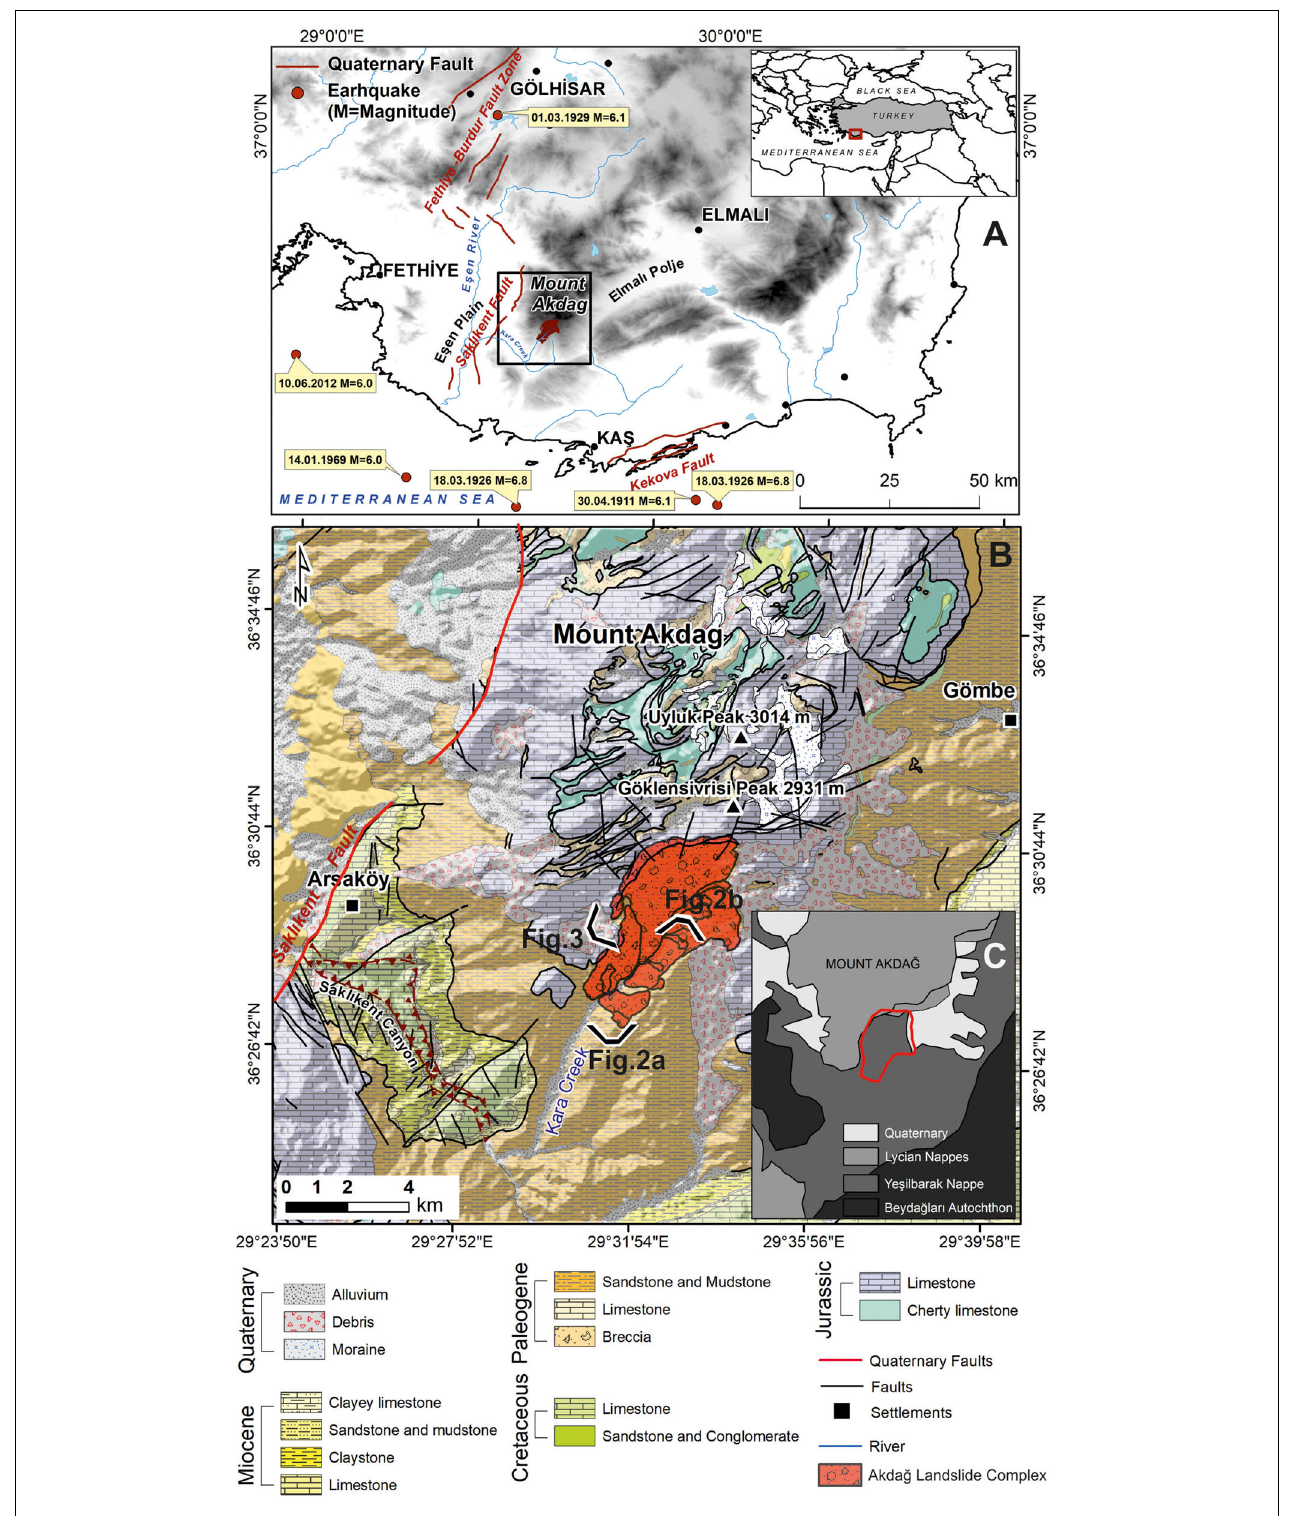
FIGURE 1 | (A) Location of Akdag Massif in southwest Turkey indicating active Quaternary faults and instrumental earthquakes and their magnitudes. (B) Generalized geology of Akdag Massif and its surroundings, SW Turkey (from ¸Senel, 1997). (C) Tectonic units of Mount Akda˘g (from ¸Senel, 1997).